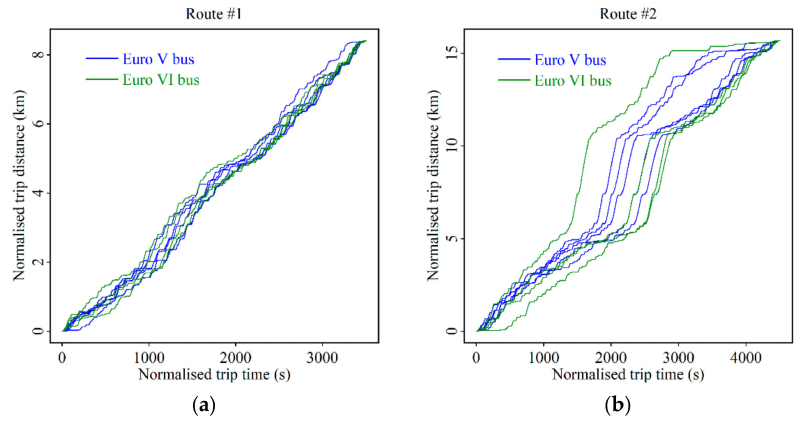
Figure 4. Normalised trip distance over normalised trip time for the conventional and hybrid buses driving on Routes #1 ( a ) and #2 ( b ).